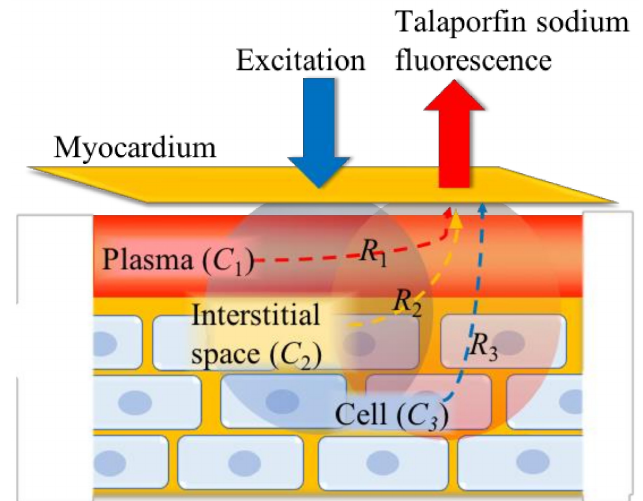
Figure 2. Origin of the measured talaporfin sodium concentration changes in the myocardium with volume ratios, R 1 , R 2 , and R 3 , which indicate the volume ratios of the plasma, interstitial space, and cell in the measured myocardial fluorescence,